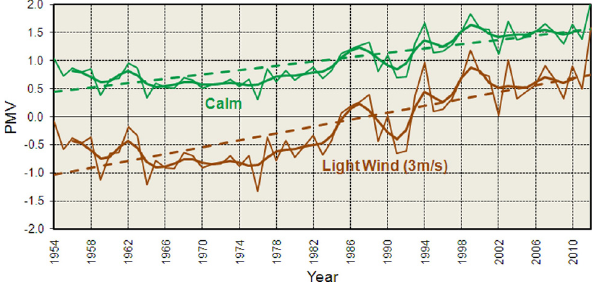
Fig. 1. Inter-annual variation of mean summer (1 May–30 Septem- ber) PMV values for Athens at 14:00 for calm and light wind con- ditions. The curves are smoothed (bold lines) using five-year mov- ing averages with binomial coefficient weights. The dashed lines indicate the statistically significant (95% confidence level) linear trends.